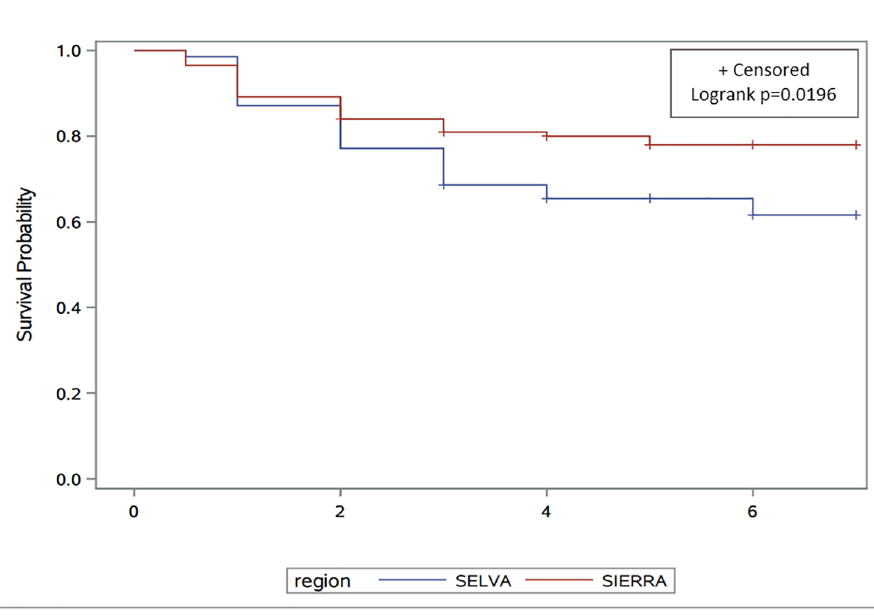
Fig 2. Kaplan-Meier survival curves for breast cancer patients from the Instituto Nacional de Enfermedades Neopla´sicas (INEN). Comparison between women from the Selva and Sierra regions of Peru. The blue line is for the Selva region and the red line for the Sierra